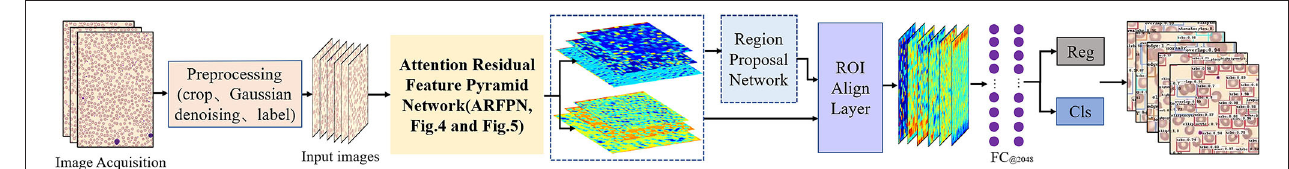
FIGURE 2 | RBC classification based on the ARFPN classification